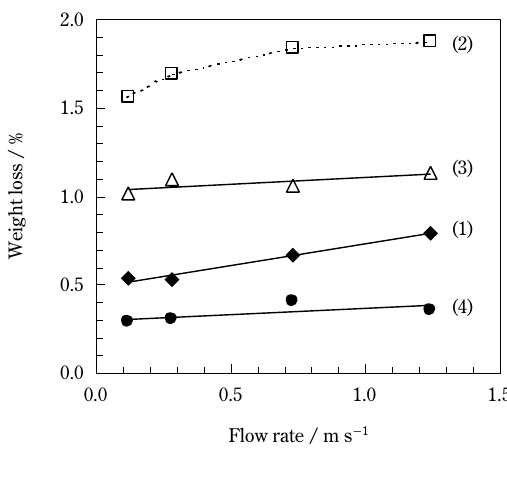
Fig. 11 Effect of mixing condition on the quantity of weight loss of BaTiO